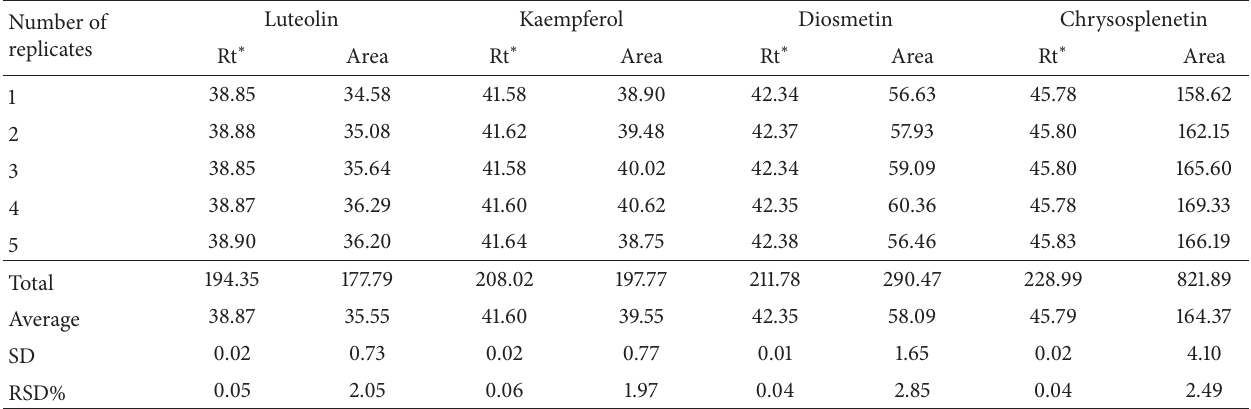
Table 2: Data obtained from the five replicate HPLC analyses for accuracy and reproducibility. Number of